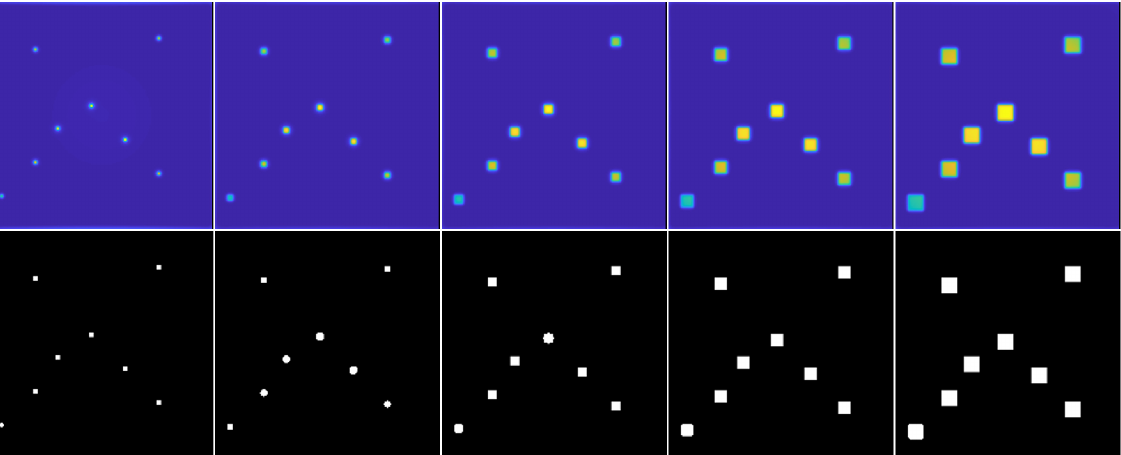
Figure 4. Automated defect detection in simulated thermal sequence maxigrams. Lateral size ( S ) of ROI-d. Column: No. 1: 3 mm, No. 2: 6 mm, No. 3: 9 mm, No. 4: 12 mm, and No. 5: 15 mm. Row No. 1: maxigrams, D = 1.0 mm. Row No. 2: resulting binary images.